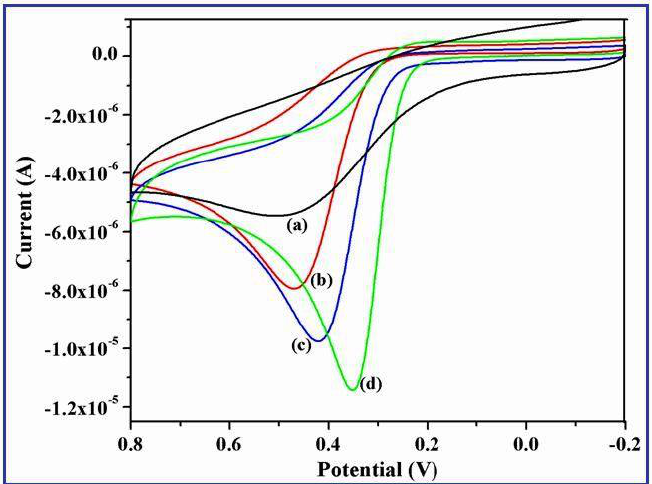
Cyclic voltammetric responses of ( a ) unmodified GCE, ( b ) γ -Fe 2 O 3 nanoparticle aggregates/GCE ( c ) γ -Fe 2 O 3 nanodots/GCE and ( d ) γ -Fe 2 O 3 nanobelts/GCE at 0.3 mM UA dissolved in 0.1 M PBS (pH 7.4) solution recorded at a scan rate of 50 mV/s.